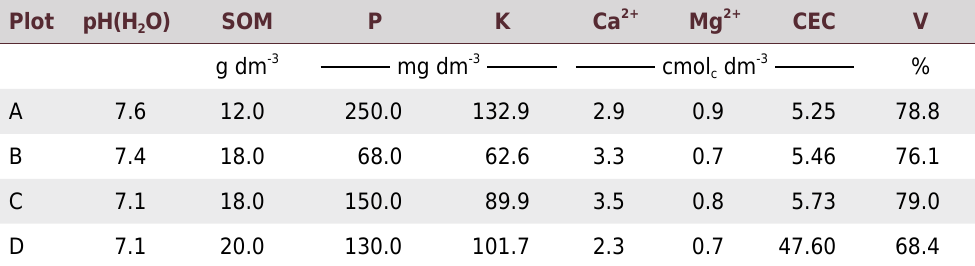
Table 3. Soil chemical properties in the 0.00-0.20 m layer for the second half of 2015, for the four plots evaluated